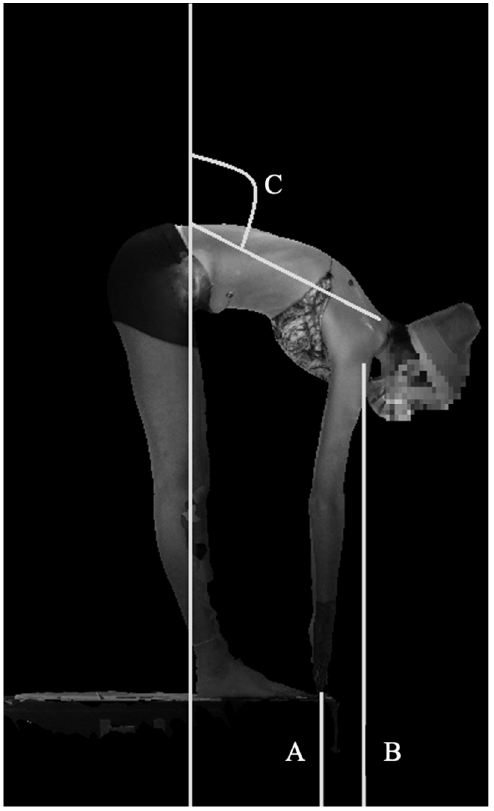
Figure 4. Forward bending measurements Line A depicts distance from fingertips to floor; line B depicts distance from acromioclavicular joint to floor. Angle C represents the sagittal angle.